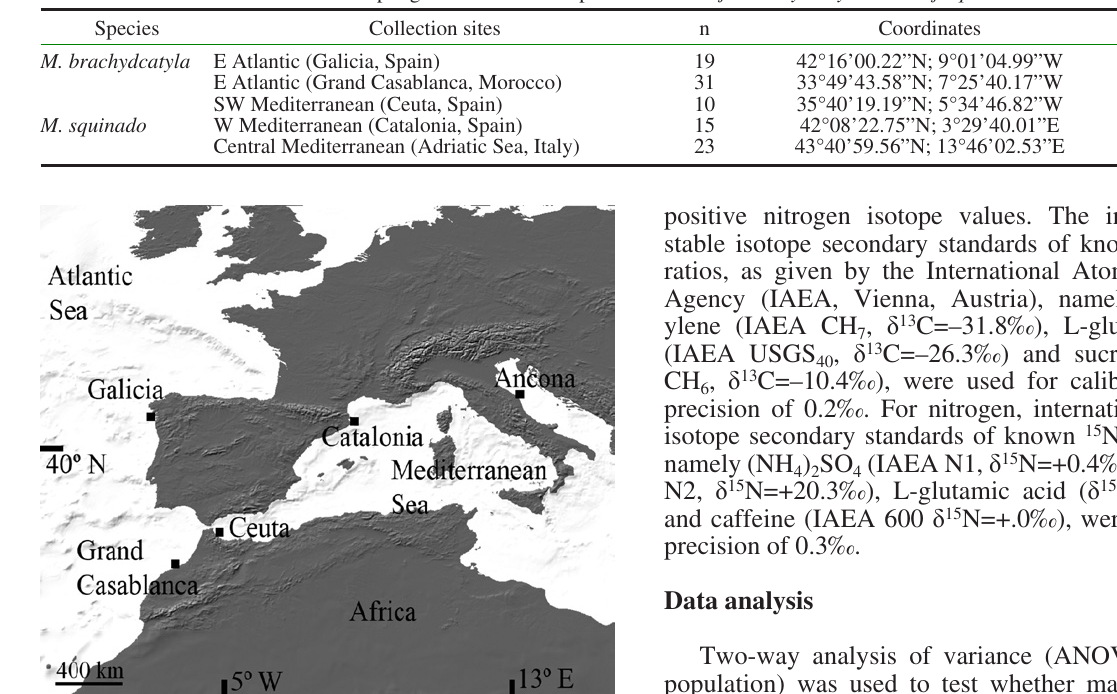
Table 1. – Sampling locations for isotope studies of Maja brachydactyla and Maja quinado .